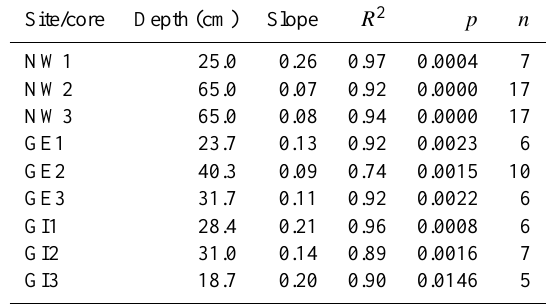
Table 1. Slope, depth and coefficient of determination of regression analyses between δ 13 C and depth until a δ 13 C value of − 25.0‰ was reached in the depth profile. Three profiles of each site – near- natural (NW), extensively managed grassland (GE) and intensively managed grassland (GI) site – from the Ahlen-Falkenberger peat- land are presented. “ n ” refers to number of soil segments per site and replication included in the